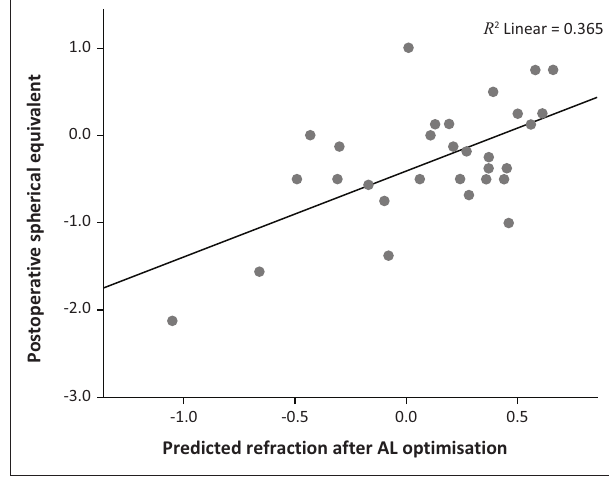
FIGURE 1: Percentage deviation of refractive outcome from predicted refraction in group 1.